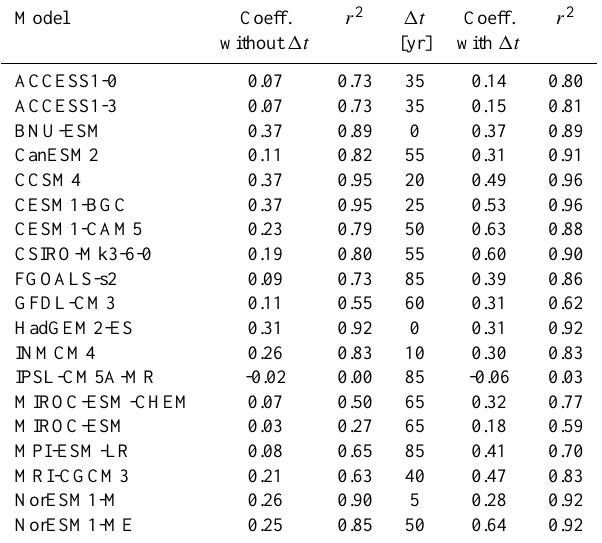
Table 3. Weddell Sea sector: scaling coefficients and time delay 1t between increases in global mean temperature and subsurface ocean temperature